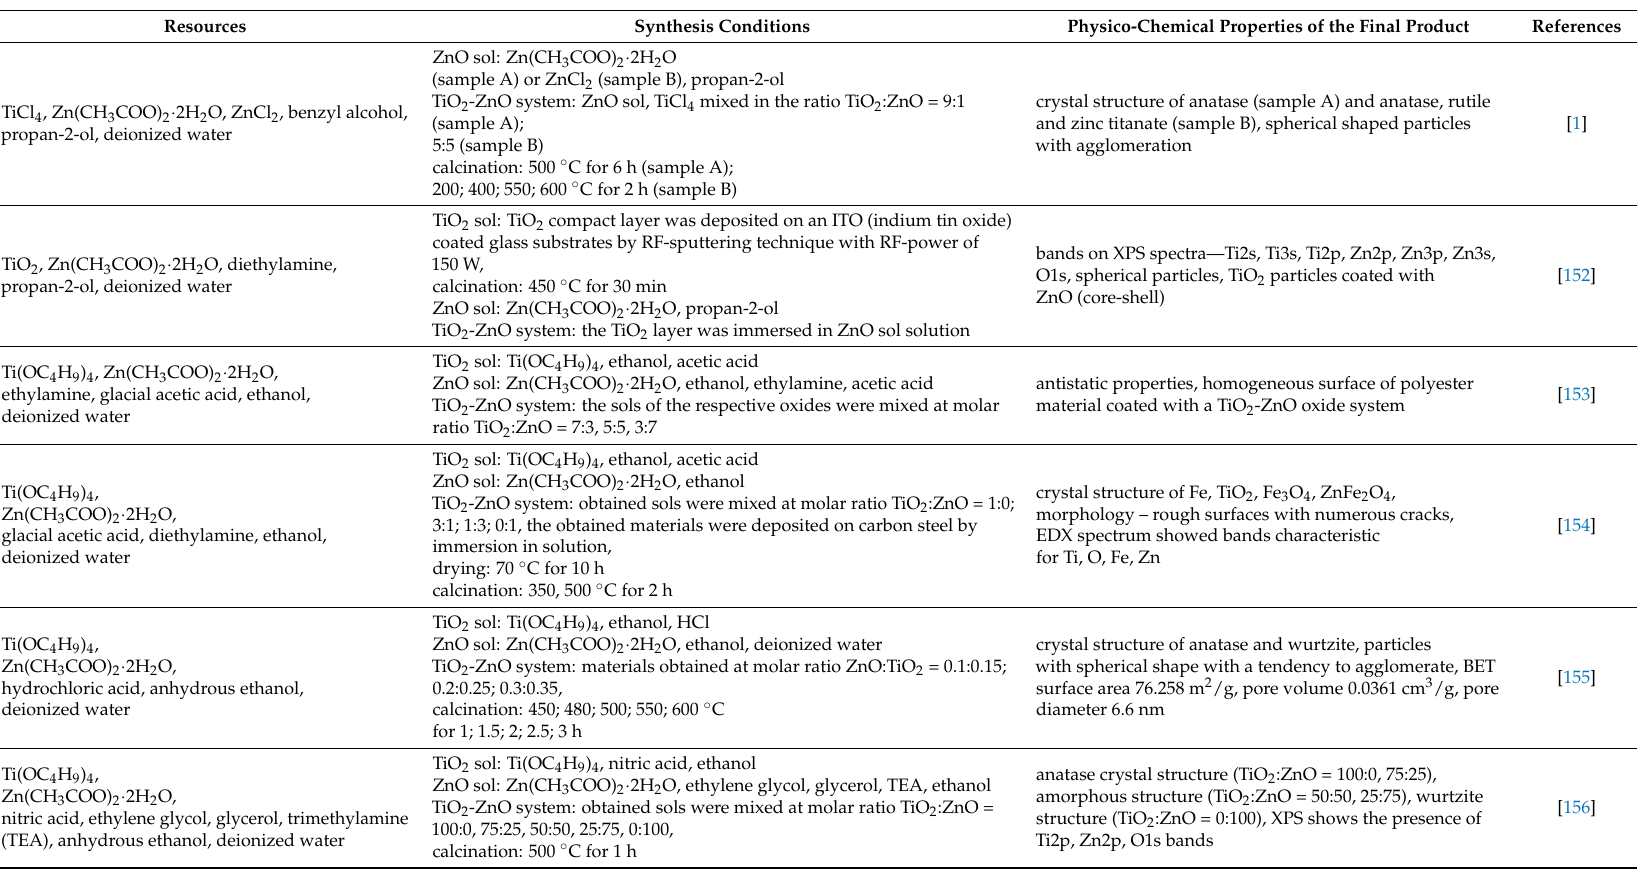
Table 4. Resources, synthesis conditions and physico-chemical properties of TiO 2 -ZnO hybrid systems obtained by the sol-gel method. Resources